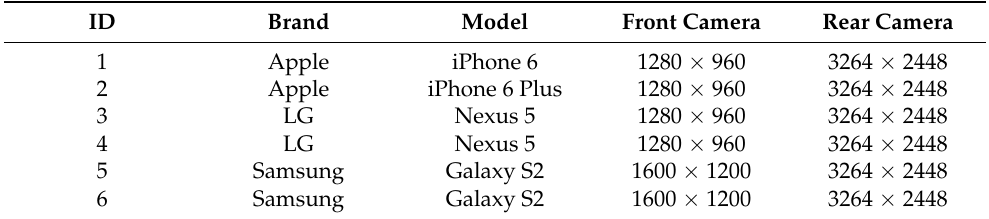
Table 2. The six smartphones used for the user-unaware watermarking tests and the pixel resolution of the front and rear cameras. ID Brand Model Front Camera Rear Camera Apple iPhone